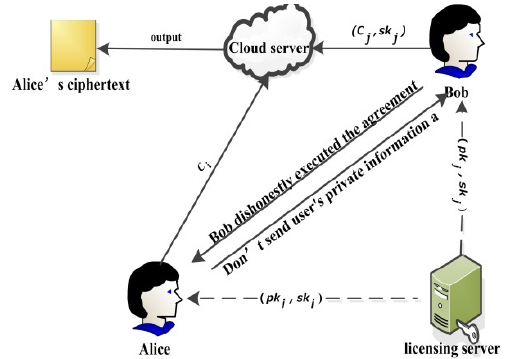
Figure 2. The collusion process between the cloud server and Bob.